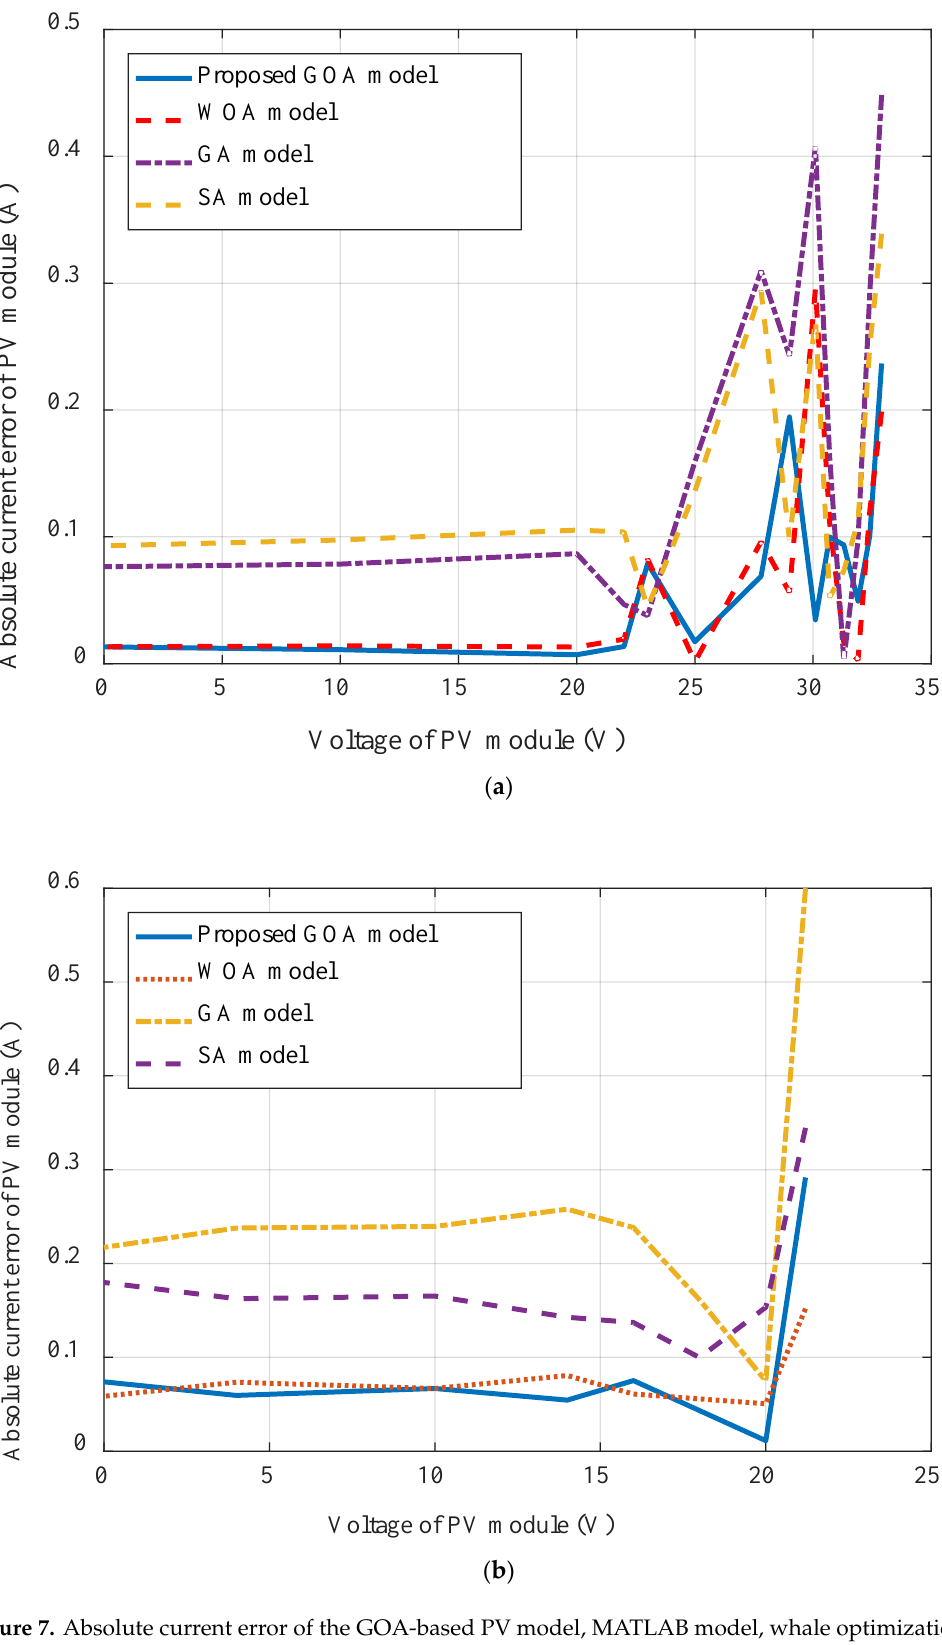
Figure 7. Absolute current error of the GOA-based PV model, MATLAB model, whale optimization algorithm (WOA) model, genetic algorithm (GA) model, and simulated annealing technique (SA) model. ( a ) KC200GT. ( b ) MSX-60.